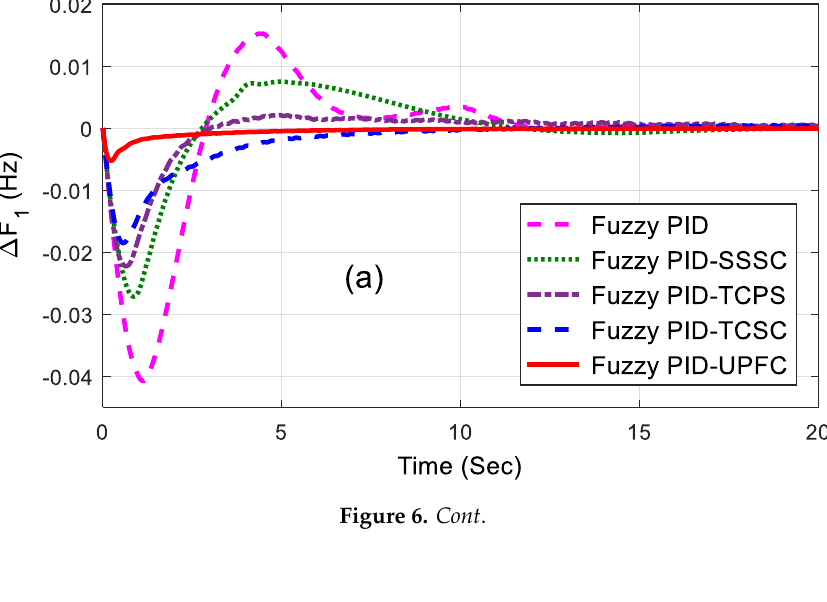
Figure 5. Single line diagram of two-area power system with unified power flow controller (UPFC).